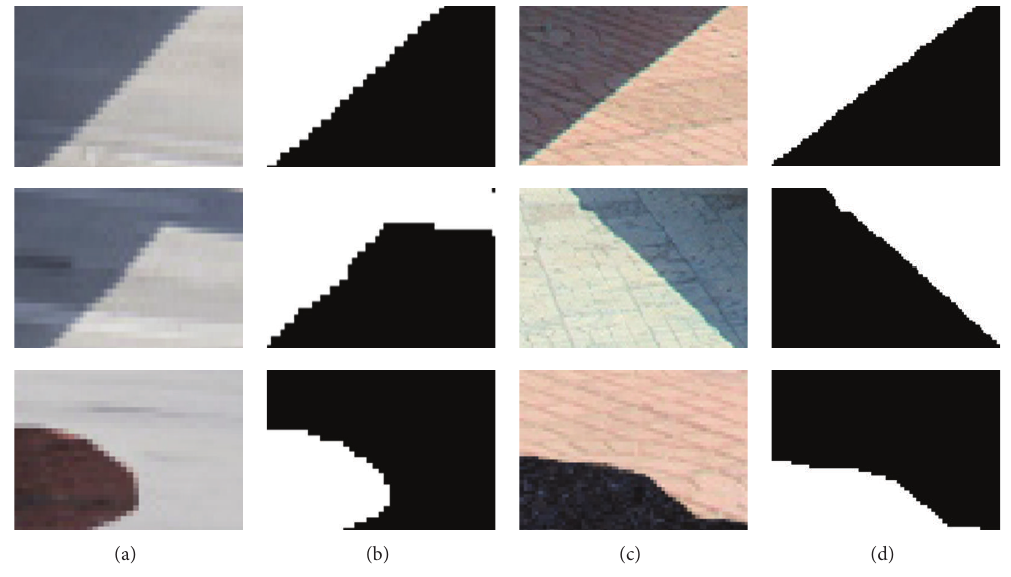
Figure 6: Sampled shadow regions and shadow